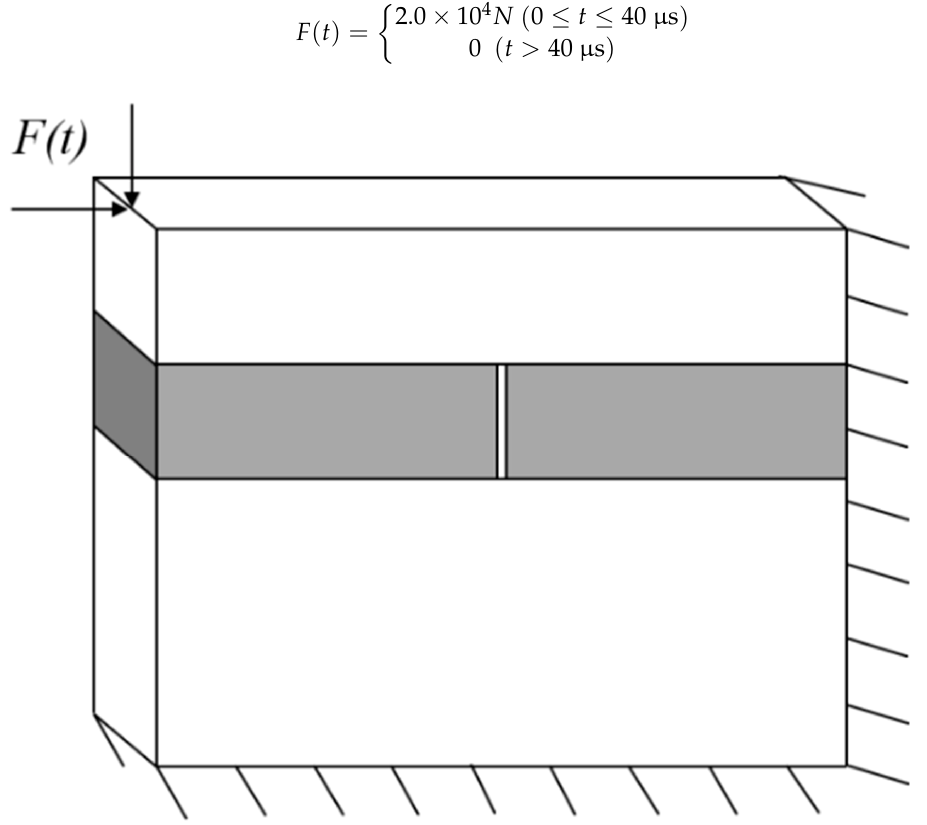
Figure 6. Geometric model and boundary conditions of 2D multilayer pavement structure.